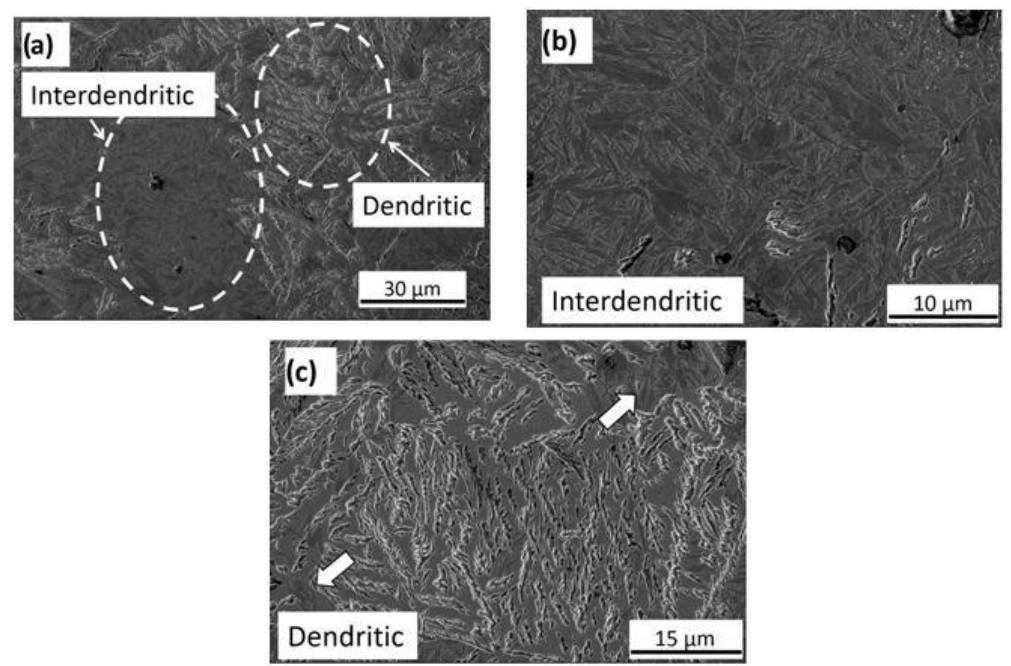
Figure 10. SEM micrographs showing: ( a ) the microstructure obtained at 330 °C for 360 min, ( b ) interdendritic and ( c ) dendritic regions. Nital 2%.